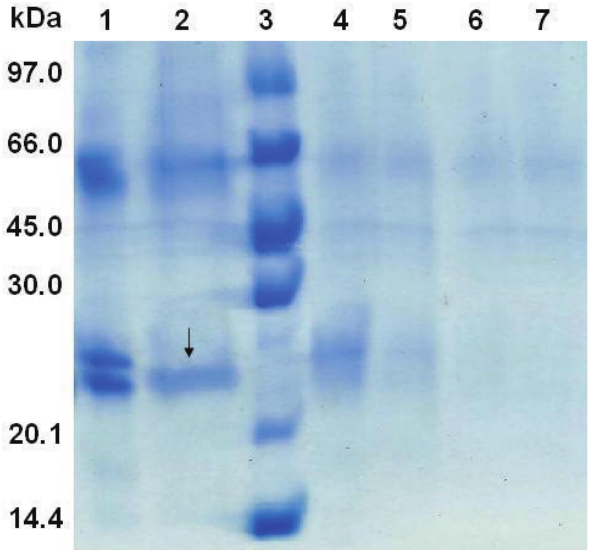
Figure 2. Comparison of the whole venom and phases from partitioning experiment, under non- reducing conditions by SDS-PAGE. Lane 1: venom. . Lanes 4, 5, 6 and 7: T Lane 2: B 4 respectively. Lane 3: Molecular weight markers (GE) phosphorylase b (97 kDa), albumin (66 kDa), ovalbumin (45 kDa), carbonic anhydrase (30 kDa), tripsyn inhibitor (20.1 kDa), and a -lactalbumin (14.4 kDa). The arrow indicates a band of 25